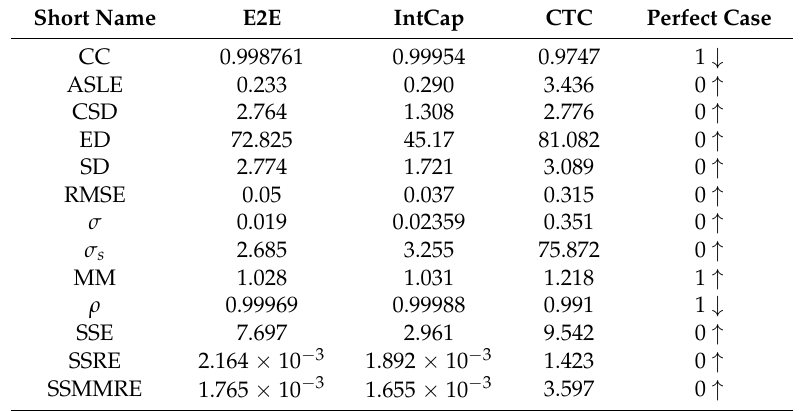
Table 3. Numerical indices results for laboratory tests—deformation 2 (frequency range 20 kHz–1.128